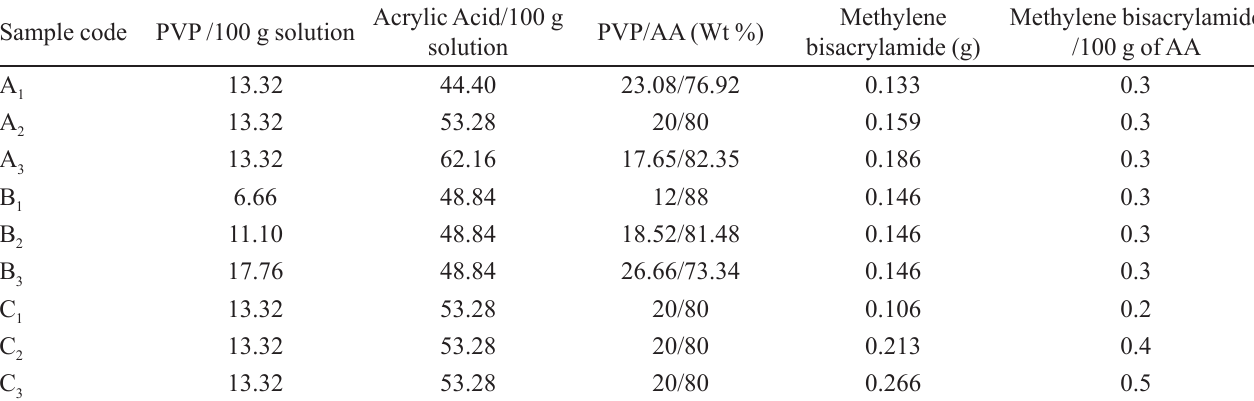
TABLE I - Formulation of PVP/AA hydrogels* Sample code